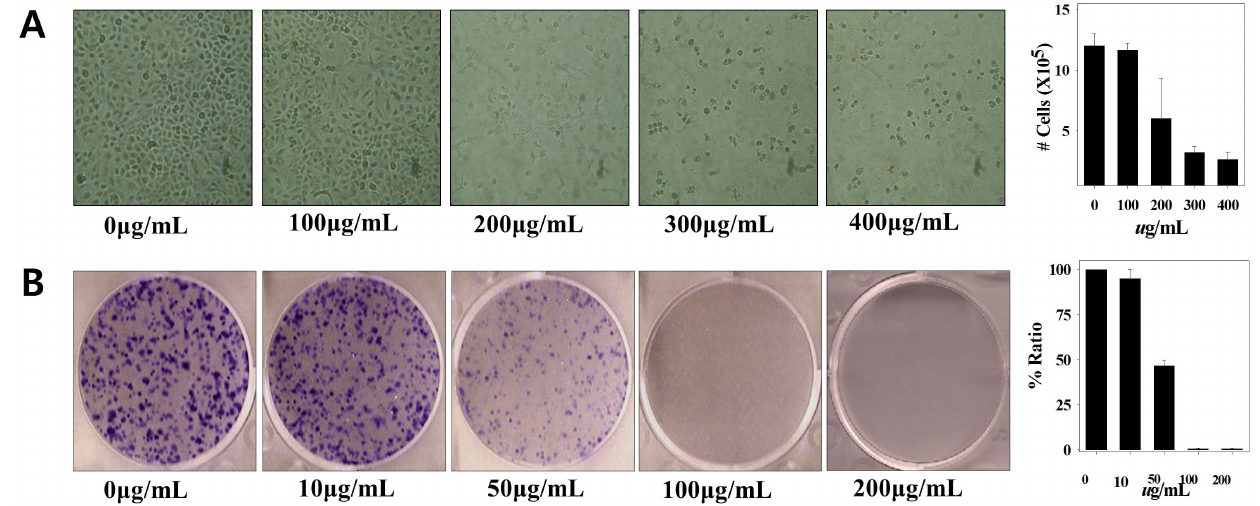
Figure 3. Inhibitory effect of MOL treatment on cell proliferation. (A) Microscopic view ( 6 1,000) and number of cells calculated by the cell counter. (B) Colony-formation assay and number of